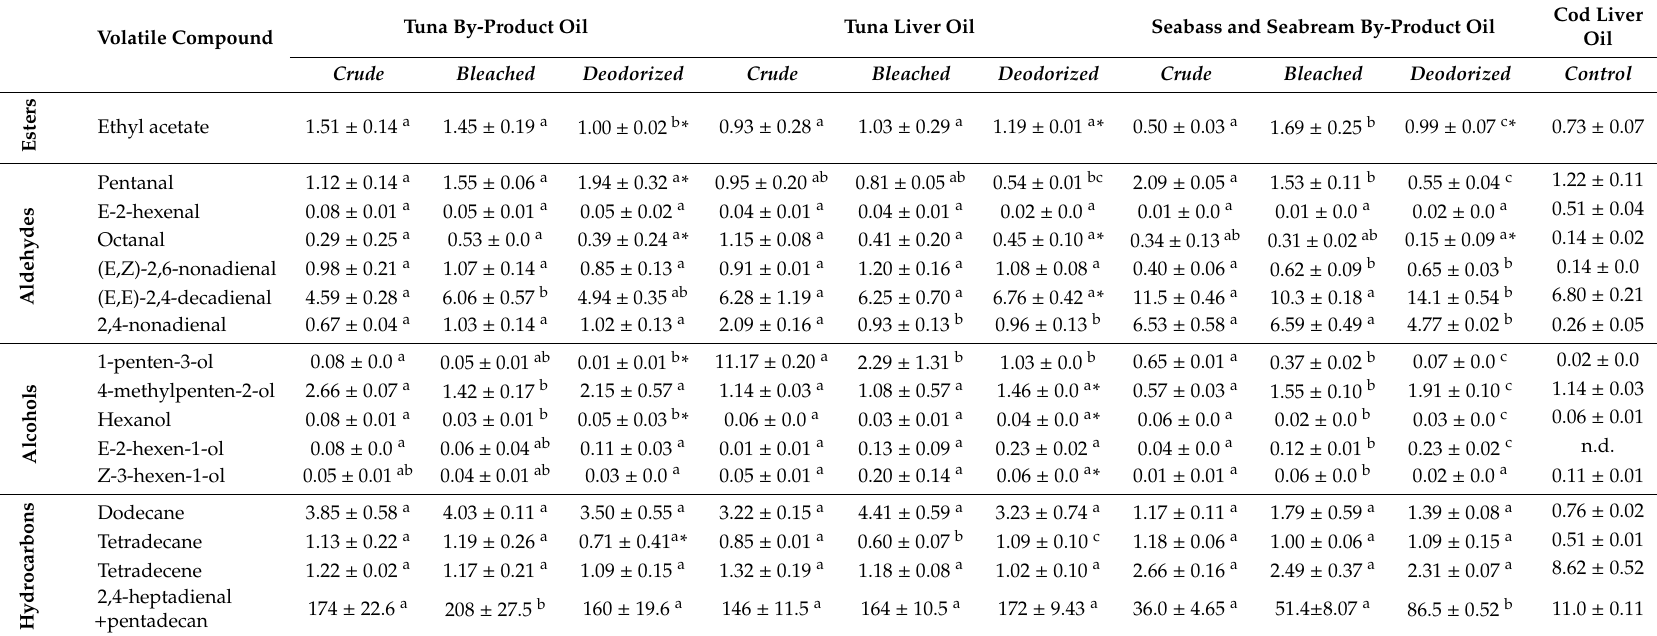
Table 3. The concentration of volatiles (mg / kg) in crude oils from tuna by-products, tuna liver, seabass and gilthead seabream by-products at di ff erent stages of the refining process, and cod liver oil